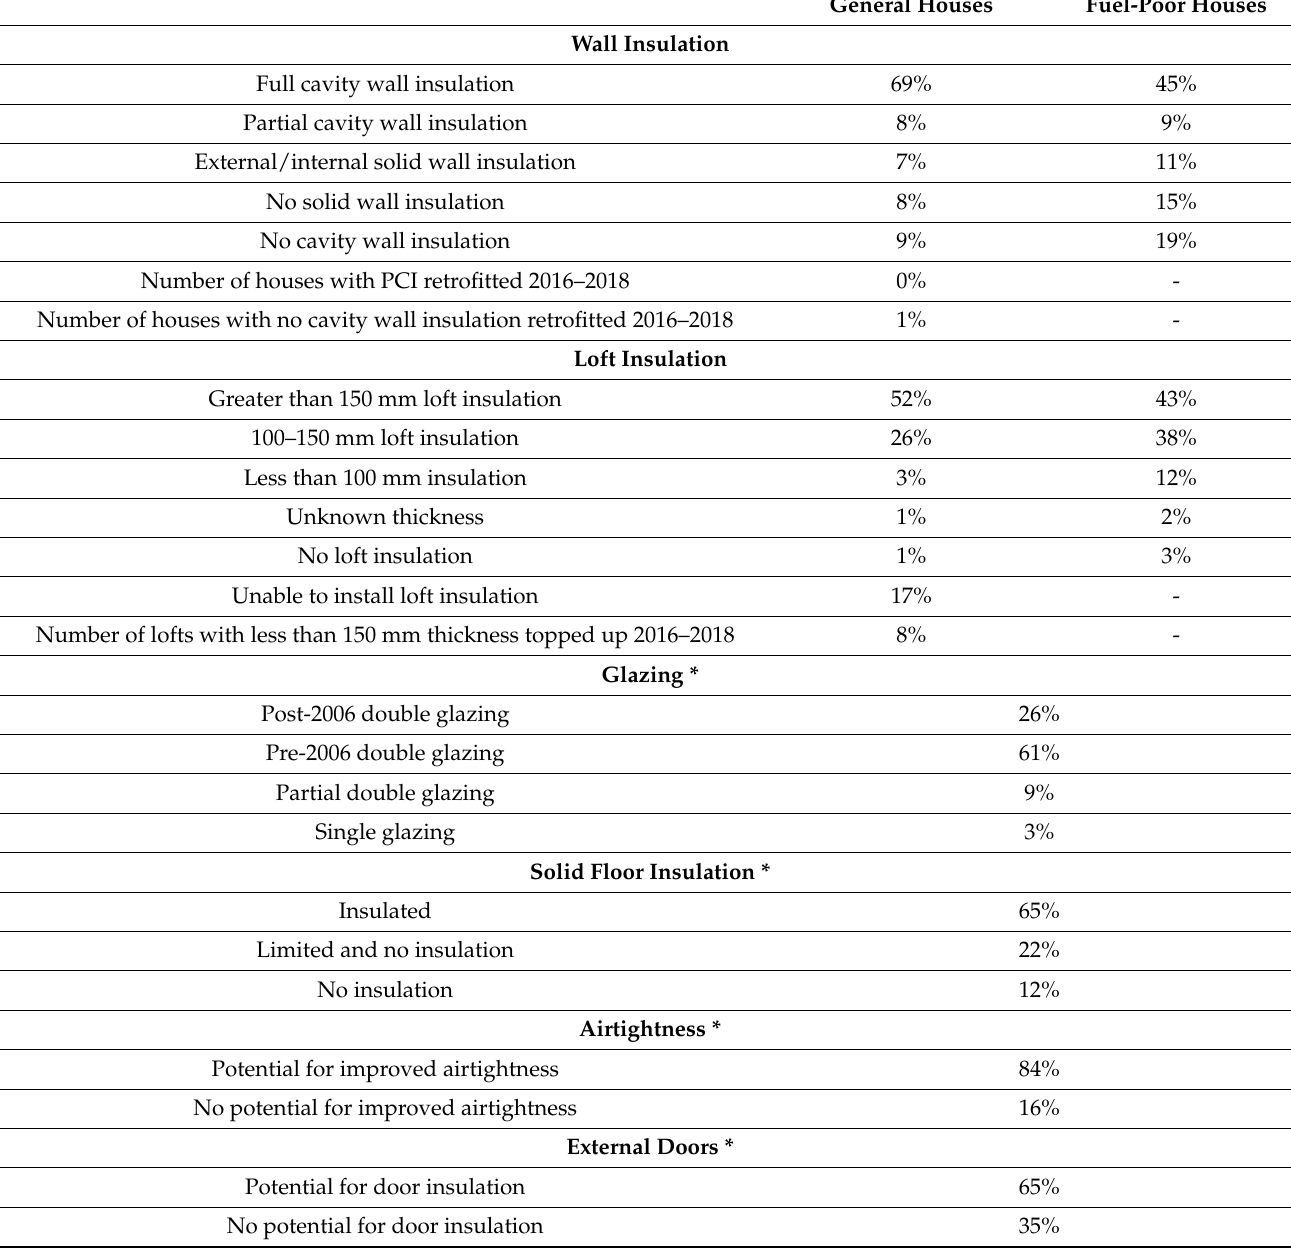
Table 1. Breakdown of houses that require retrofitting based on total number of entire housing stock and total number of houses in fuel